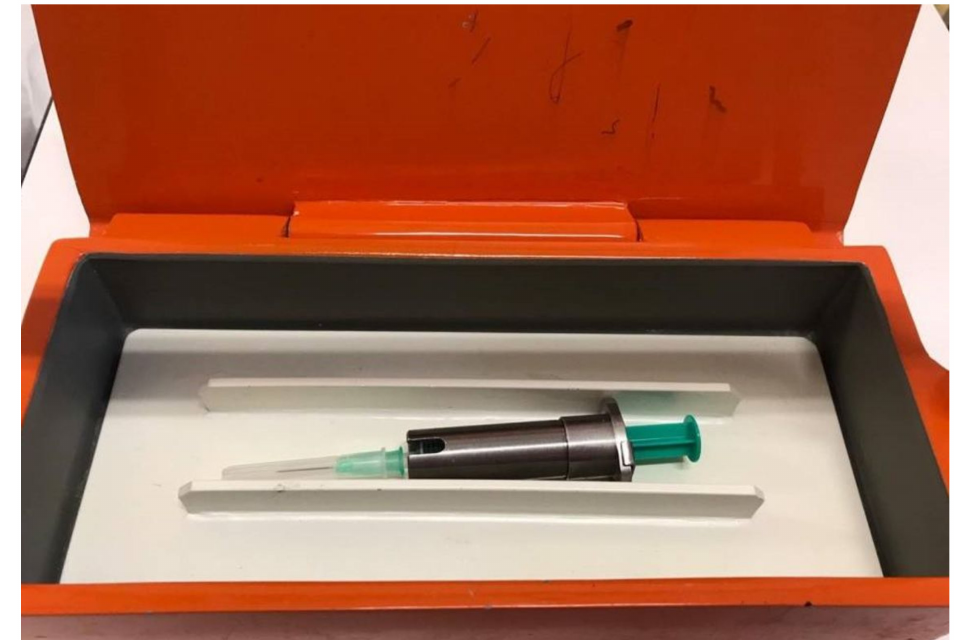
Figure 1. Shielded syringe with radioisotope (2 mL of 111